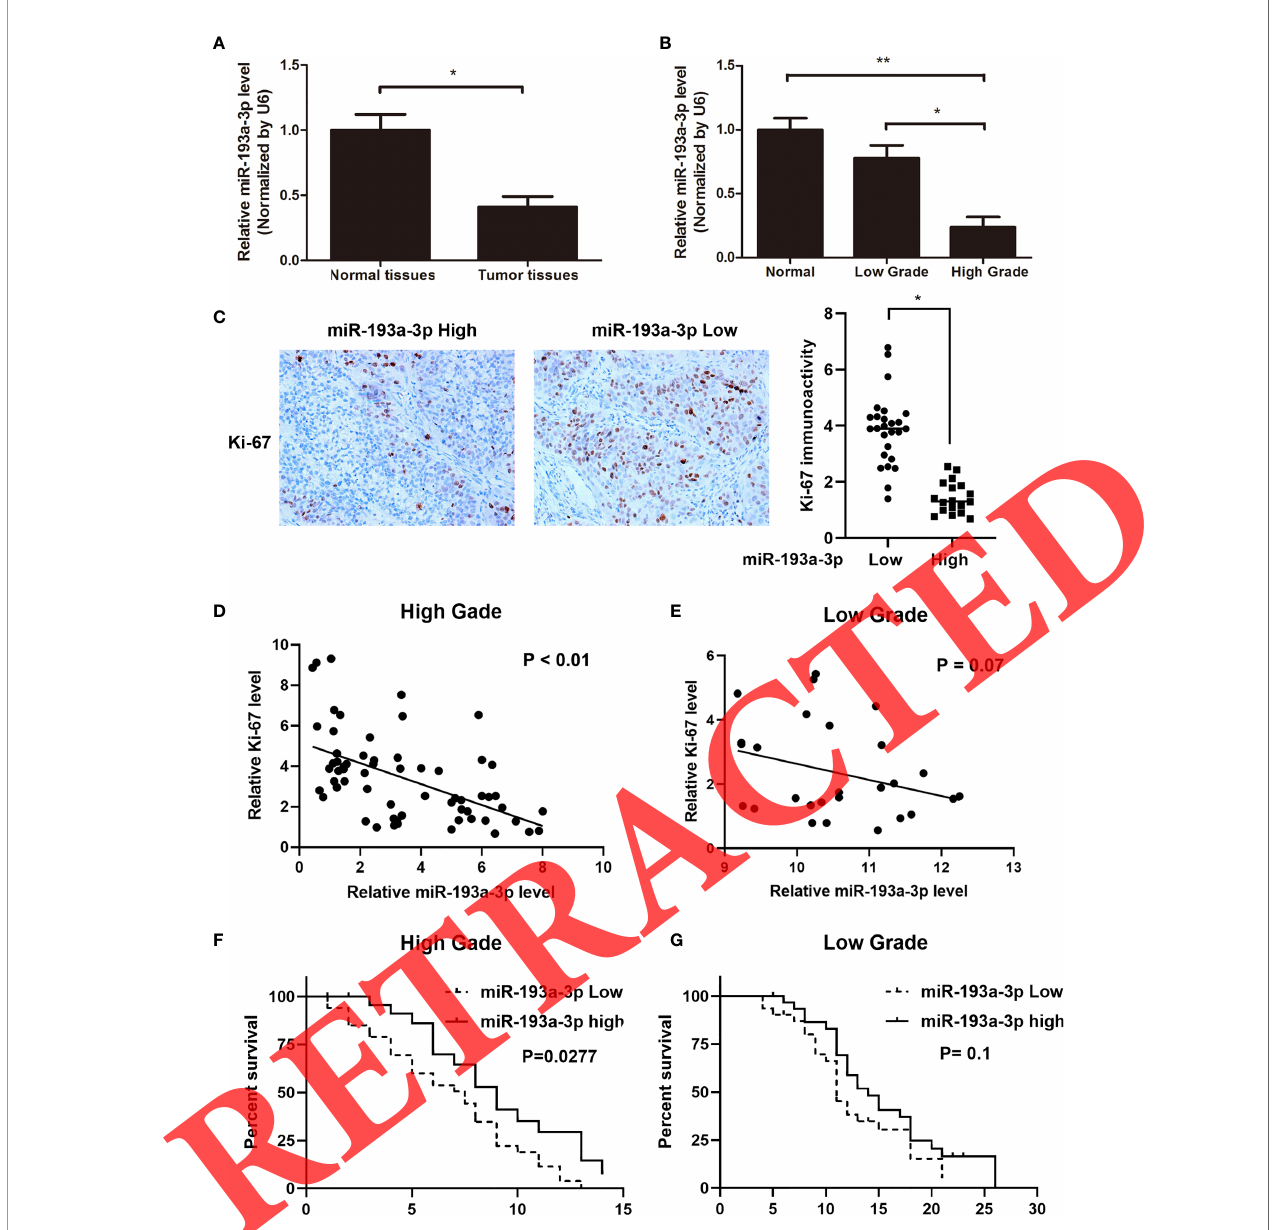
FIGURE 1 | (A) Expression levels of miR-193a-3p in glioma tissues (tumor tissues) and the adjacent tissues (normal tissues) were determined by qRT-PCR. *P<0.05. (B) Expression levels of miR-193a-3p in gliomas of different pathological grade were determined by qRT-PCR. *P<0.05 and **P<0.01. (C) . Left: Representative immunostaining showed expression of Ki-67 in miR-193a-3p high and in miR-193a-3p low-expressing tumors. Right: Quantitative analysis of Ki-67 immunoactivity. *P<0.05. (D) Correlation between Ki-67 inmmunocativity and miR-193a-3p expression in high-grade gliomas. r=-0.53, P<0.01. (E) No signi fi cant correlation was found between Ki-67 inmmunocativity and miR-193a-3p expression in low-grade gliomas. r=-0.33, P=0.07. (F) Kaplane-Meier survival curves in patients with high-grade gliomas according to the expression of miR-193a-3p. Patient tumors were analyzed by qRT-PCR for miR-193a-3p expression and divided into high and low expression groups as described in Results. P=0.00277. (G) No signi fi cant correlation was found between miR-193a-3p expression and survival probability in low-grade gliomas.